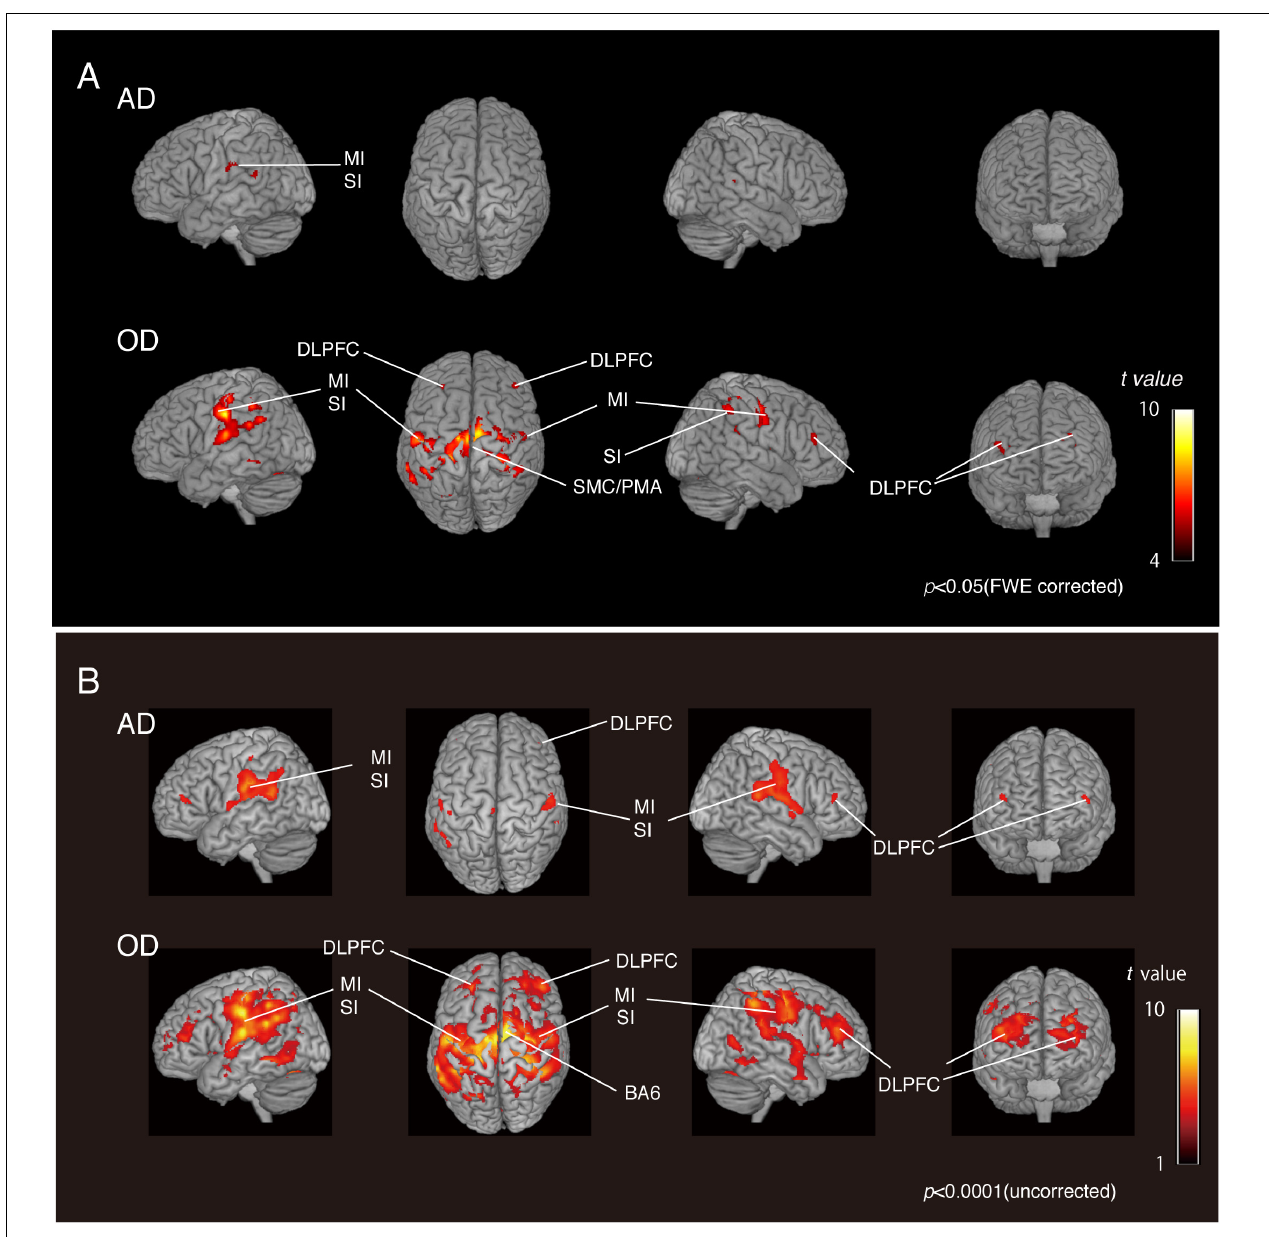
FIGURE 2 | BOLD activation pattern. (A) Surface projection of statistical parametric maps superimposed onto a standard MNI template brain ( p < 0.05, FWE corrected). Significant increases in signals associated with tapping in the AD group (upper section) and OD group (lower section) . The color bar shows the t -values. (B) Surface projection of statistical parametric maps superimposed onto a standard MNI template brain ( p < 0.0001, uncorrected). Significant increases in signals associated with tapping in the AD group (upper section) and OD group (lower section) . The color bar shows the t -values. Activated regions from uncorrected results provide some additional cortical activations to FWE corrected results (A) , suggesting that the vast number of statistical tests may lead to false positive results regardless of the analysis approach